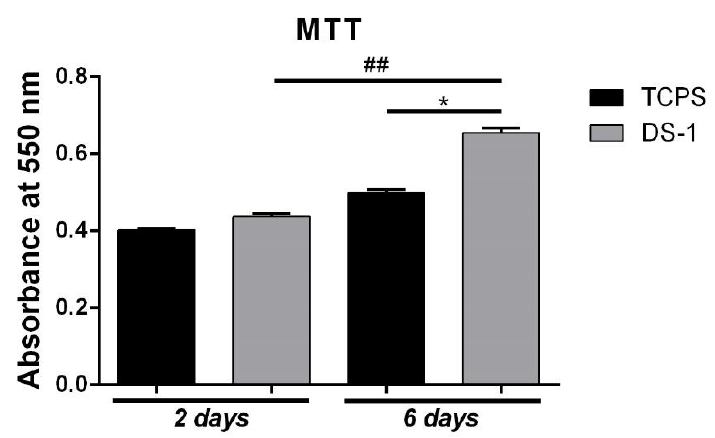
Figure 6. Cell viability and proliferation profile registered for DS-1 after two and six days of culture, evaluated by MTT assay. Statistical significance: * p < 0.05 (DS-1 six days versus TCPS six days); ## p < 0.01 (DS-1 six days versus DS-1 two days).